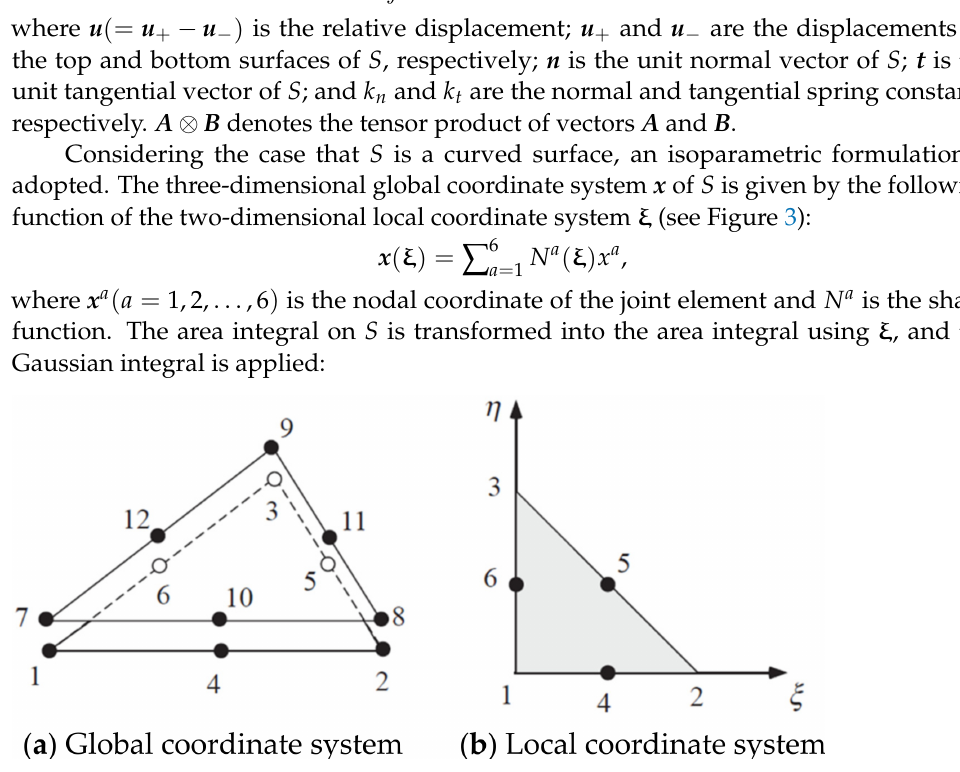
Figure 3. Three-dimensional second-order triangular joint element and its local coordinate